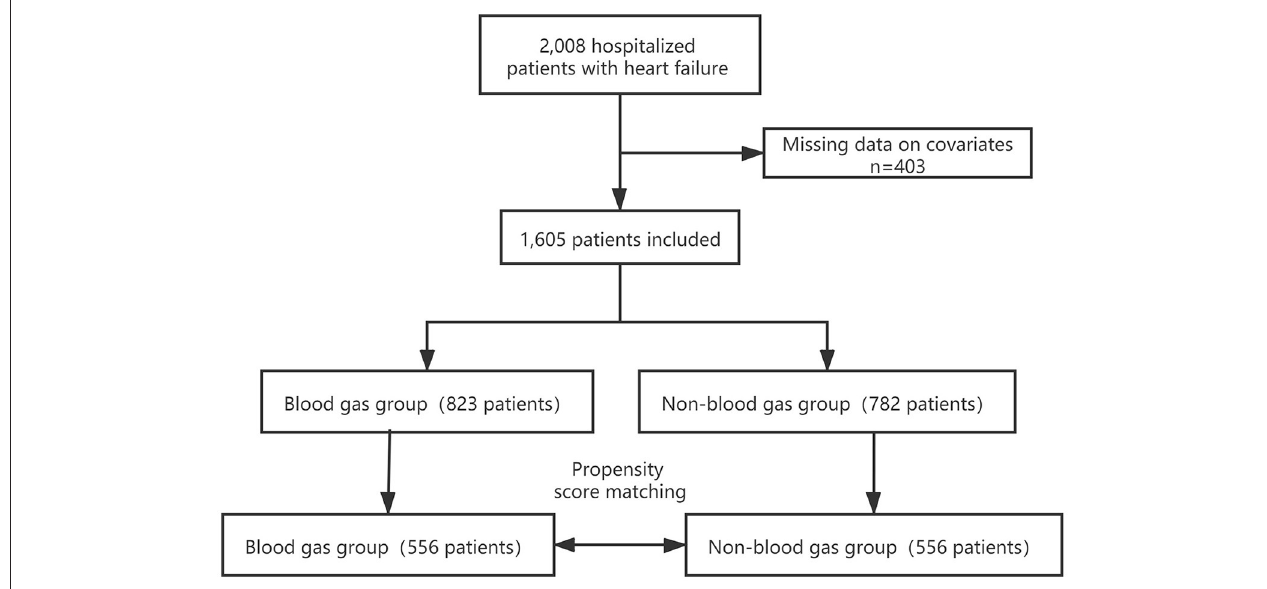
FIGURE 1 | Flow chart of the screening and enrollment of study